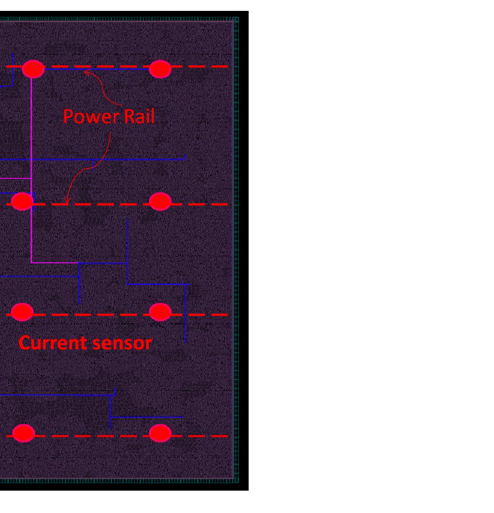
Fig 6. The layout of the AES chip with 16 current sensors.